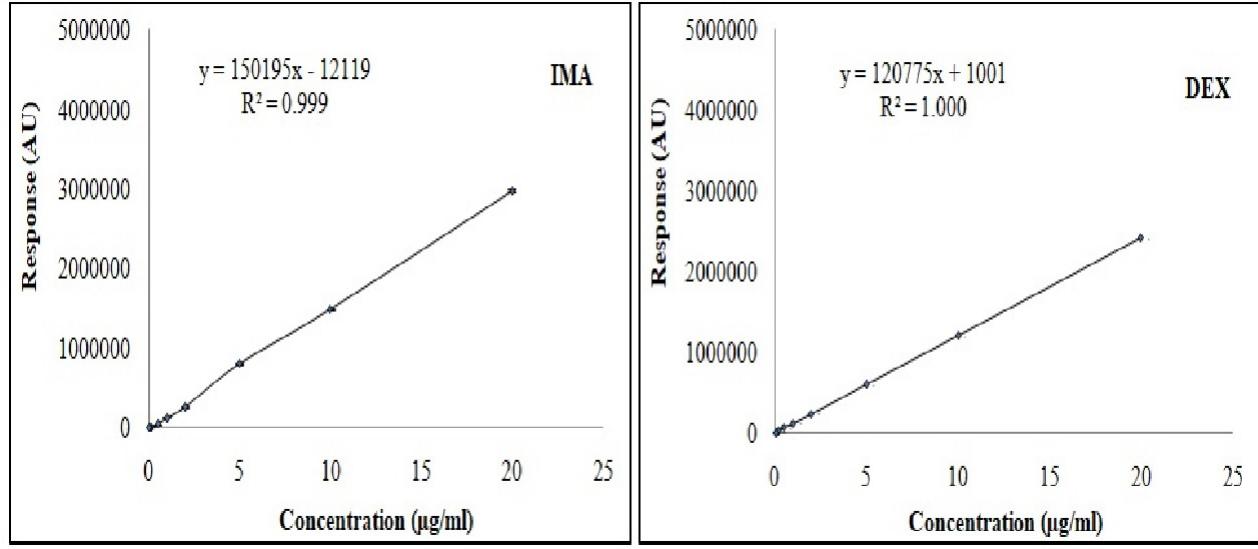
FIGURE 3 - The calibration curves of imatinib mesylate and dexketoprofen trometamol in distilled water (n=6).